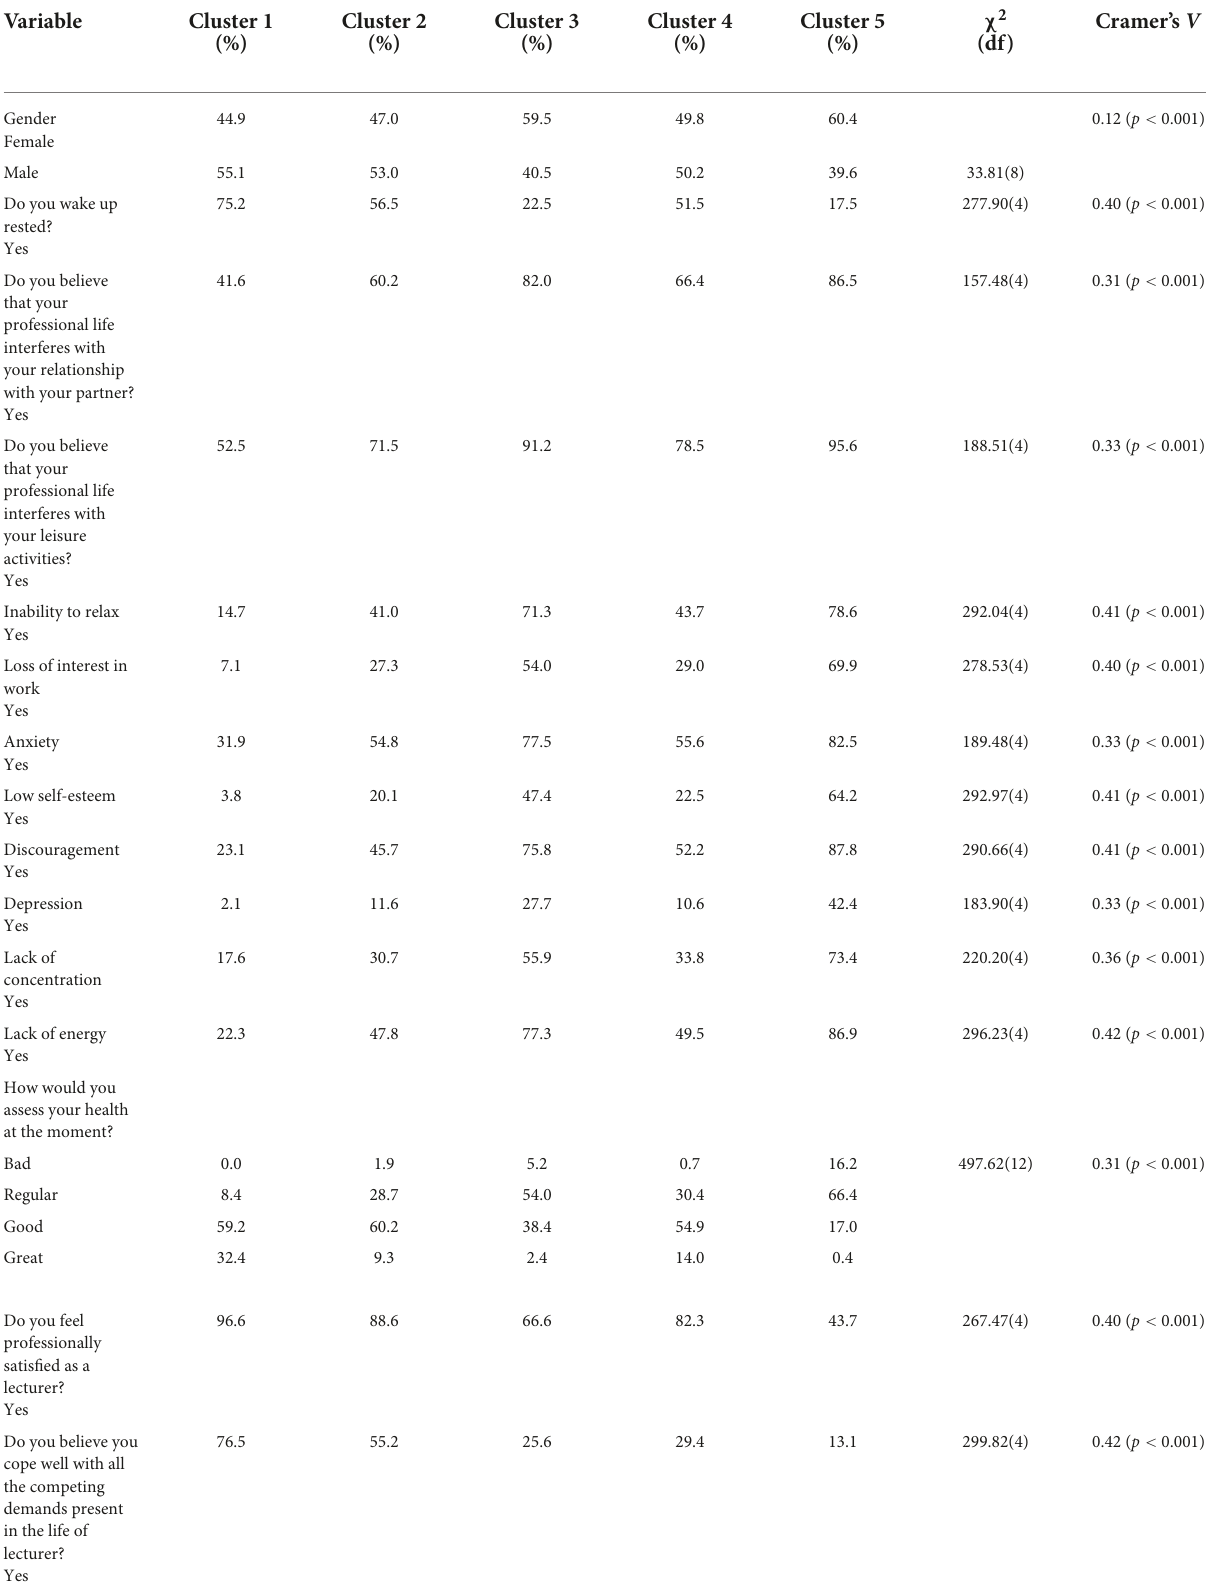
TABLE 5 Pattern of group responses according to the frequency of personal variables.